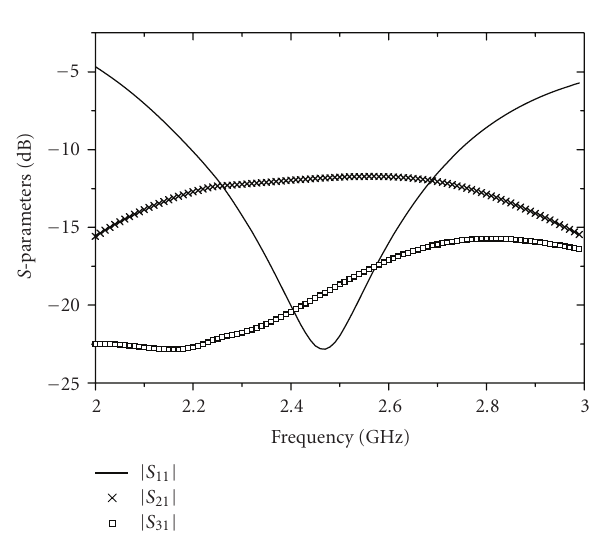
Normalized distance between two monopoles ( D/λ 0